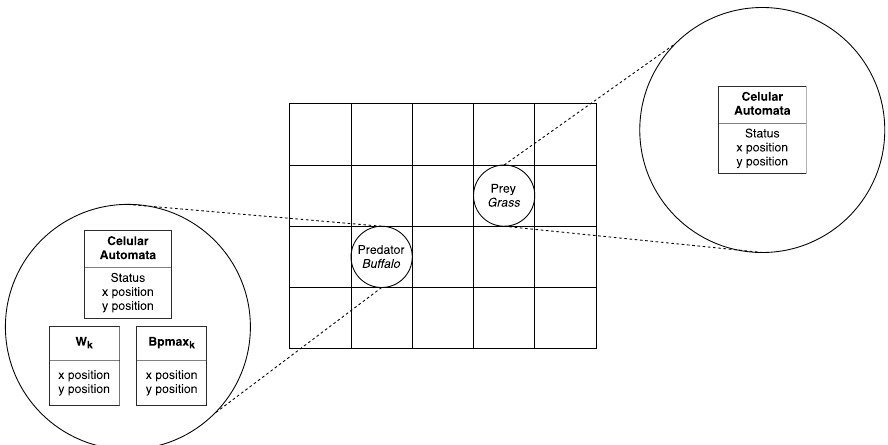
Figure 4. Cellular automata with African buffalo optimization.